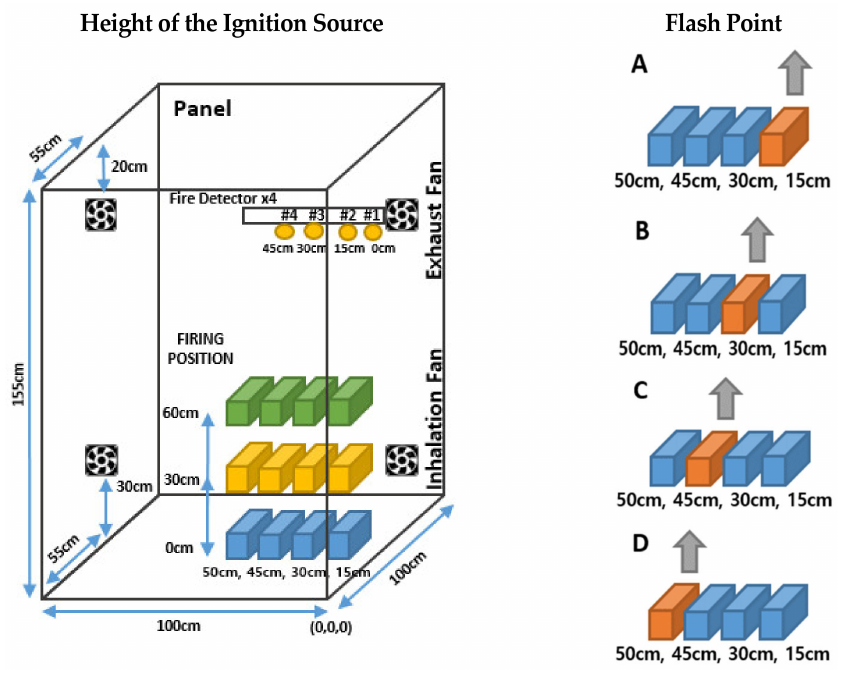
Figure 11. Height of the ignition